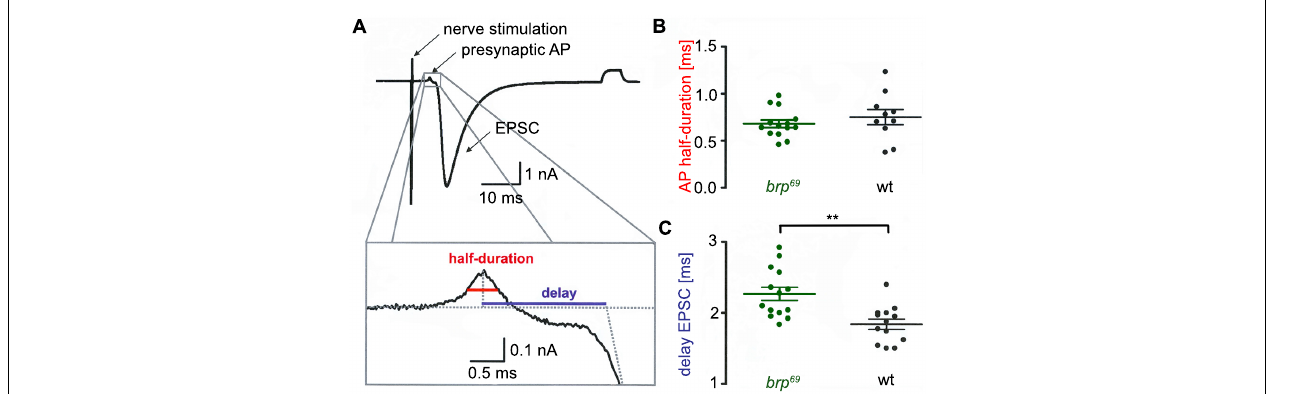
upward deflection (right side of the trace and allowed to measure electrode and seal resistance).The lower panel shows the enlarged presynaptic AP and illustrates how half-duration of the positive AP deflection (red) and synaptic delay (blue) were determined. (B) While AP half-duration is unchanged between brp 69 (green) and wt (black), (C) synaptic delay is prolonged in brp 69 . Shown are single values (dots) and mean ±